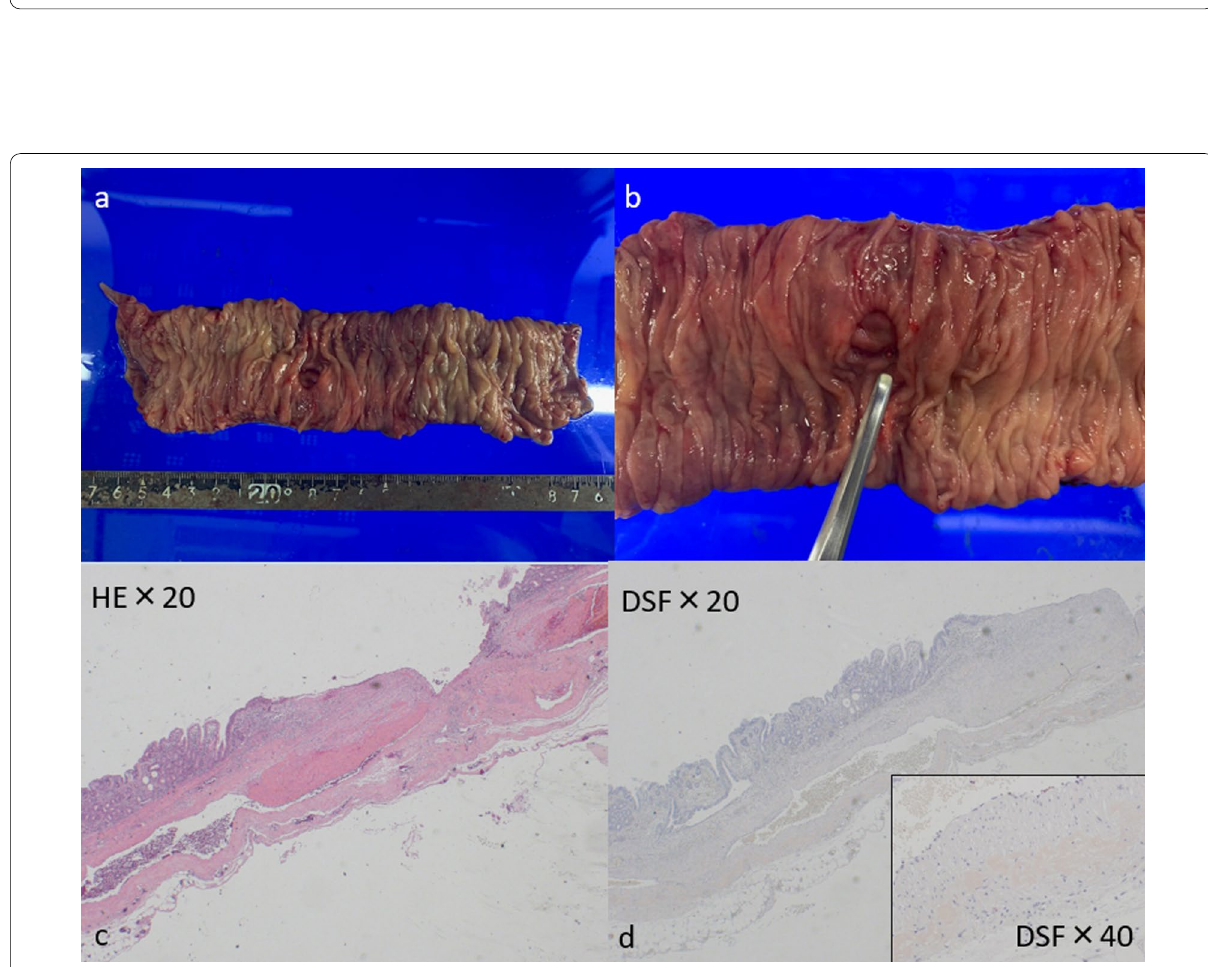
orange with DFS staining, which suggested intestinal